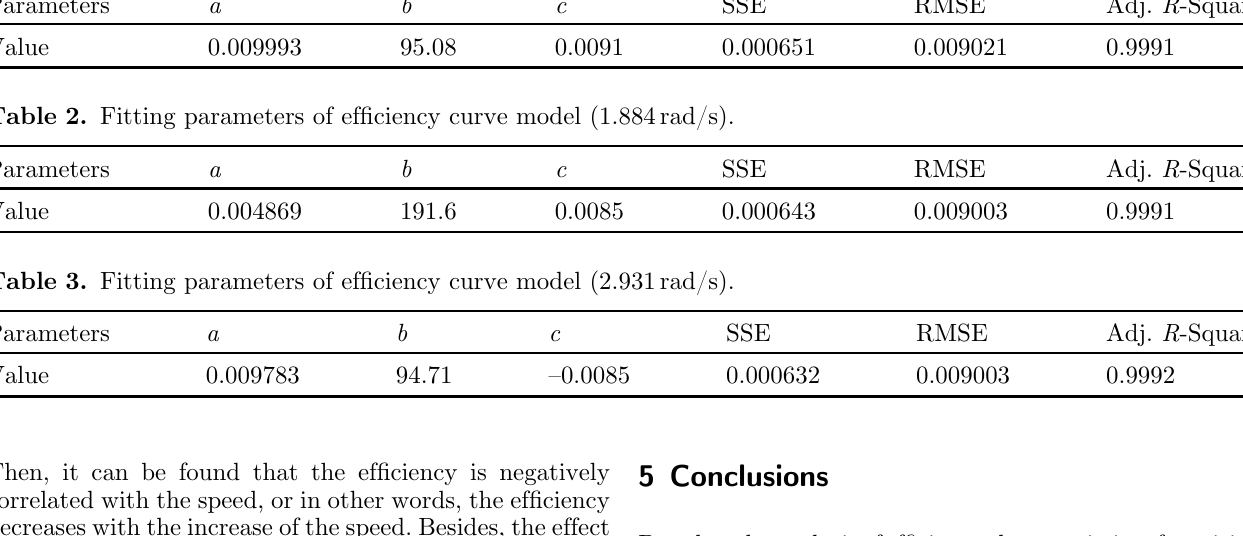
Table 1. Ef fi ciency curve model fi tting parameters. Parameters